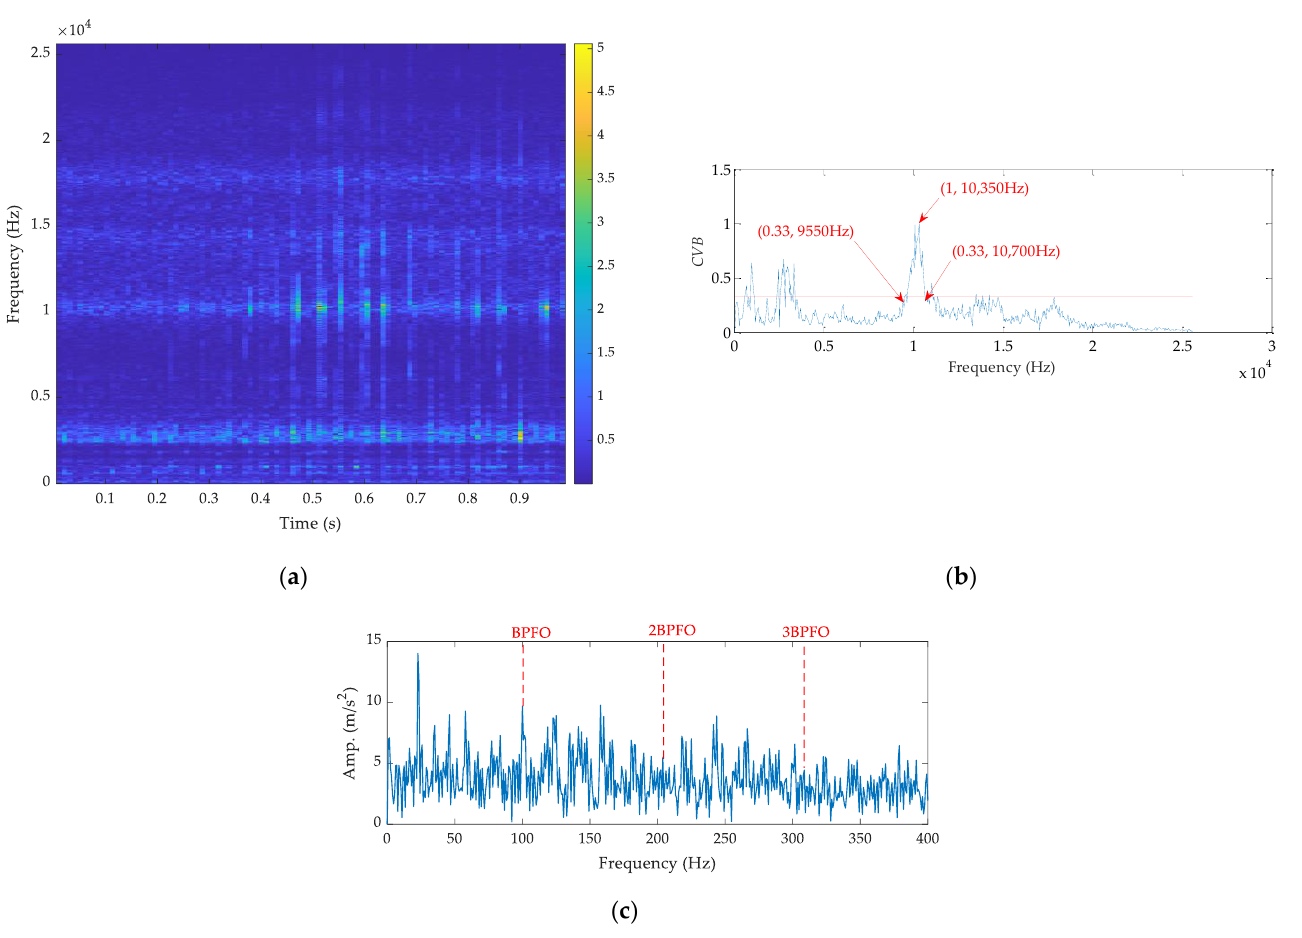
Figure 13. The results by CVB technology for the outer fault signal: ( a ) time – frequency spectrum, ( b ) CVB vs. frequency, and ( c ) SES.